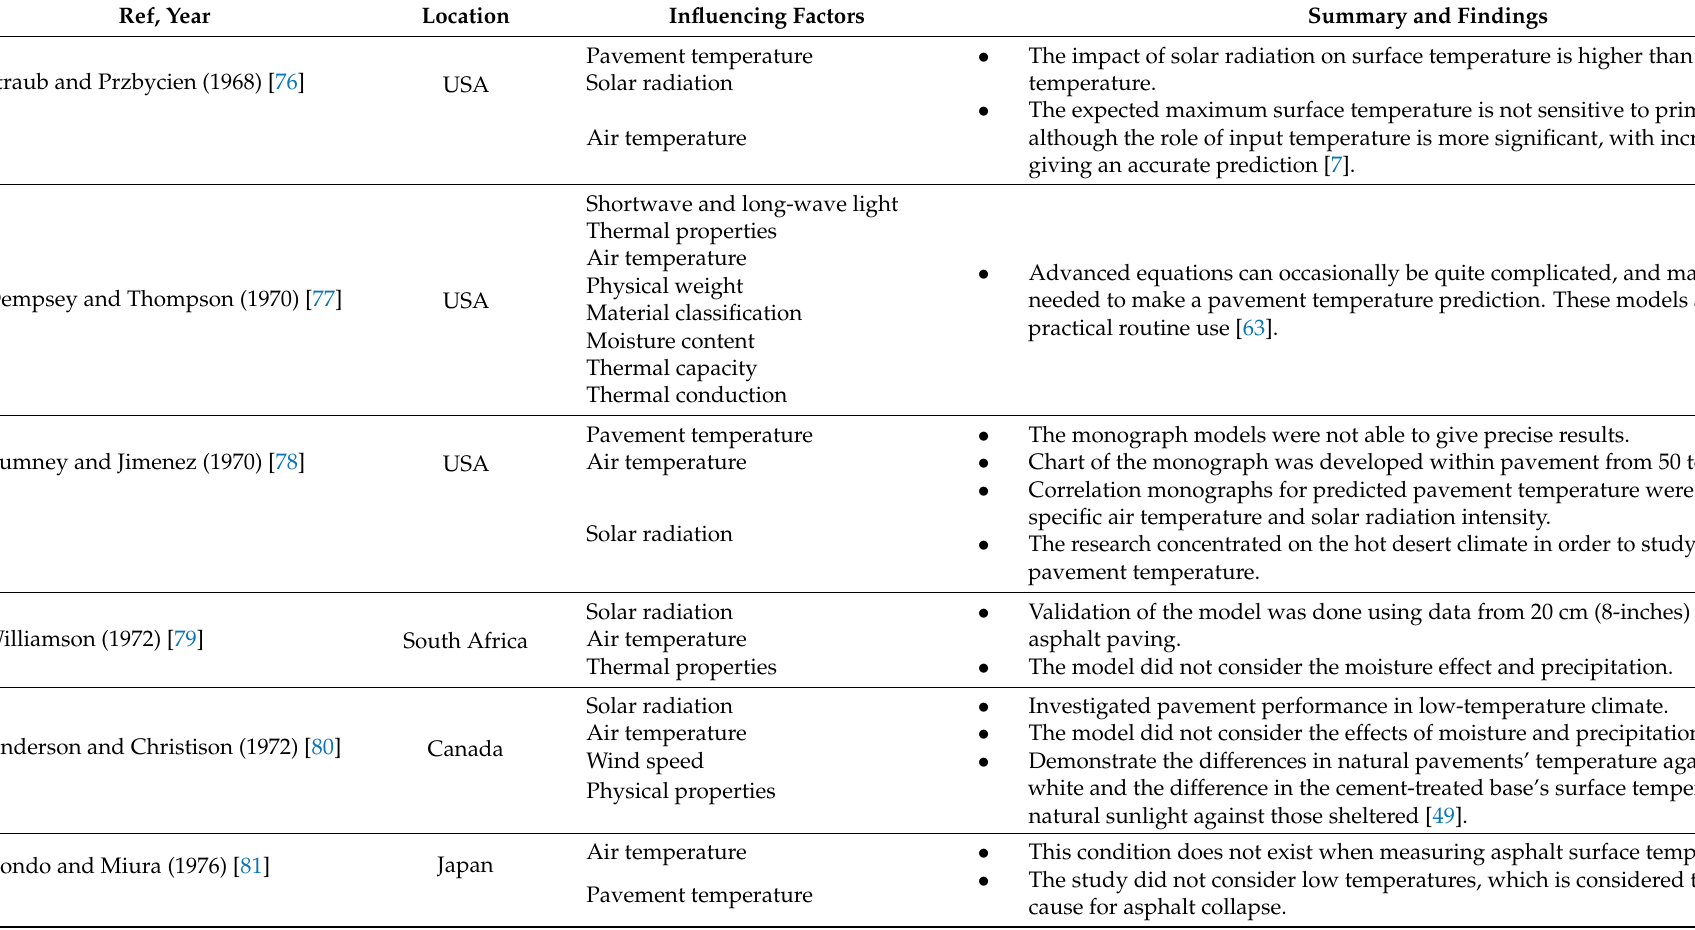
Table 1. Pavement temperature prediction models using numerical